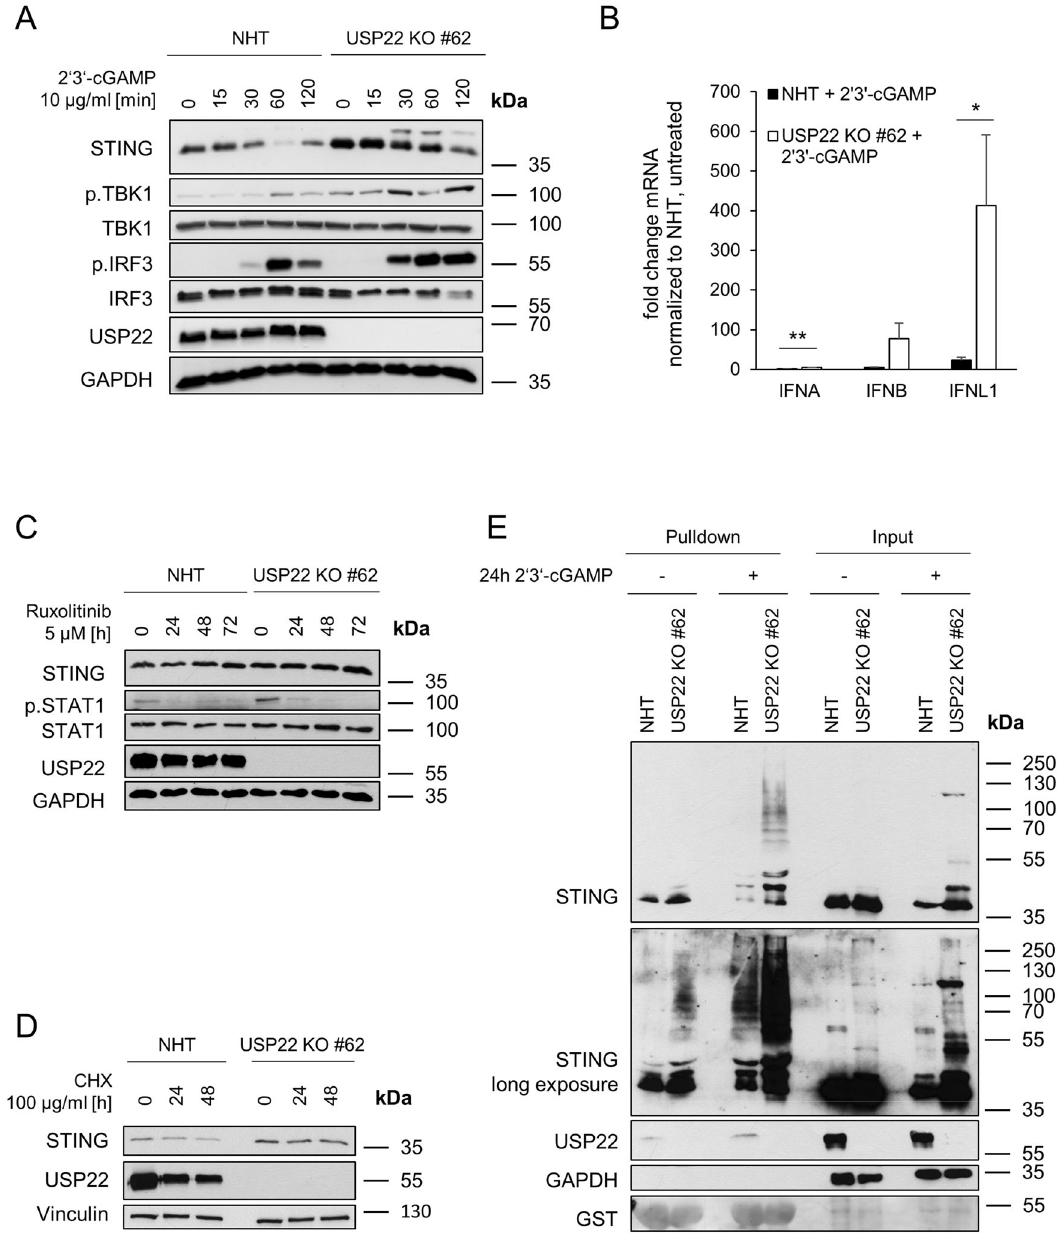
Fig. 5 USP22 negatively regulates STING activation and ubiquitination. A Western blot analysis of STING, phosphorylated and total TBK1, phosphorylated and total IRF3 and USP22 expression levels in control (NHT) and CRISPR/Cas9-generated USP22 KO HT-29 single clone (USP22 KO #62) subjected to 2 ’ 3 ’ -cGAMP (10 µg/ml) for the indicated time points. GAPDH served as loading control. Representative blots of at least two different independent experiments are shown. B mRNA expression levels of IFNA, IFNB, and IFNL1 in control and USP22 KO HT-29 cells (USP22 KO #62) subjected to 2 ’ 3 ’ -cGAMP (10 µg/ml) for 3 h. Gene expression was normalized against 28 S mRNA and is presented as x-fold mRNA expression compared to NHT. Mean and SD of three independent experiments in triplicate are shown. * P < 0.05; ** P < 0.01. C Western blot analysis of STING, phosphorylated and total STAT1 and USP22 expression levels in control and USP22 KO HT-29 cells (USP22 KO #62) subjected to the JAK/STAT inhibitor ruxolitinib (5 µM) for the indicated time points. GAPDH served as loading control. Representative blots of at least two different independent experiments are shown. D Western blot analysis of STING and USP22 expression levels in control and USP22 KO HT-29 cells (USP22 KO #62) subjected to CHX (100 µg/ml) for the indicated time points. Vinculin served as loading control. Representative blots of at least two different independent experiments are shown. E Western blot analysis of TUBE-enriched ubiquitin- modi fi ed STING from control and USP22 KO HT-29 cells (USP22 KO #62) subjected to 2 ’ 3 ’ -cGAMP (10 µg/ml) for 24 h. GAPDH served as loading control and Ponceau S staining con fi rms equal loading of GST-TUBE beads. Representative blots of at least two different independent experiments are shown. fi xed at 24 h post-infection (hpi) and subjected to quanti fi cation of To test the functional relevance of the increased antiviral SARS-CoV-2 replication via immuno fl uorescence with the NP signaling upon loss of USP22 expression, WT, NHT, and USP22 KO antibody recognizing SARS nucleocapsid protein. Interestingly, Caco-2 cells were subjected to infection with SARS-CoV-2 particles USP22-de fi cient cells displayed a prominent decrease in SARS- at a multiplicity of infection (MOI) of 1. Infected Caco-2 cells were Cell Death and Disease (2022)